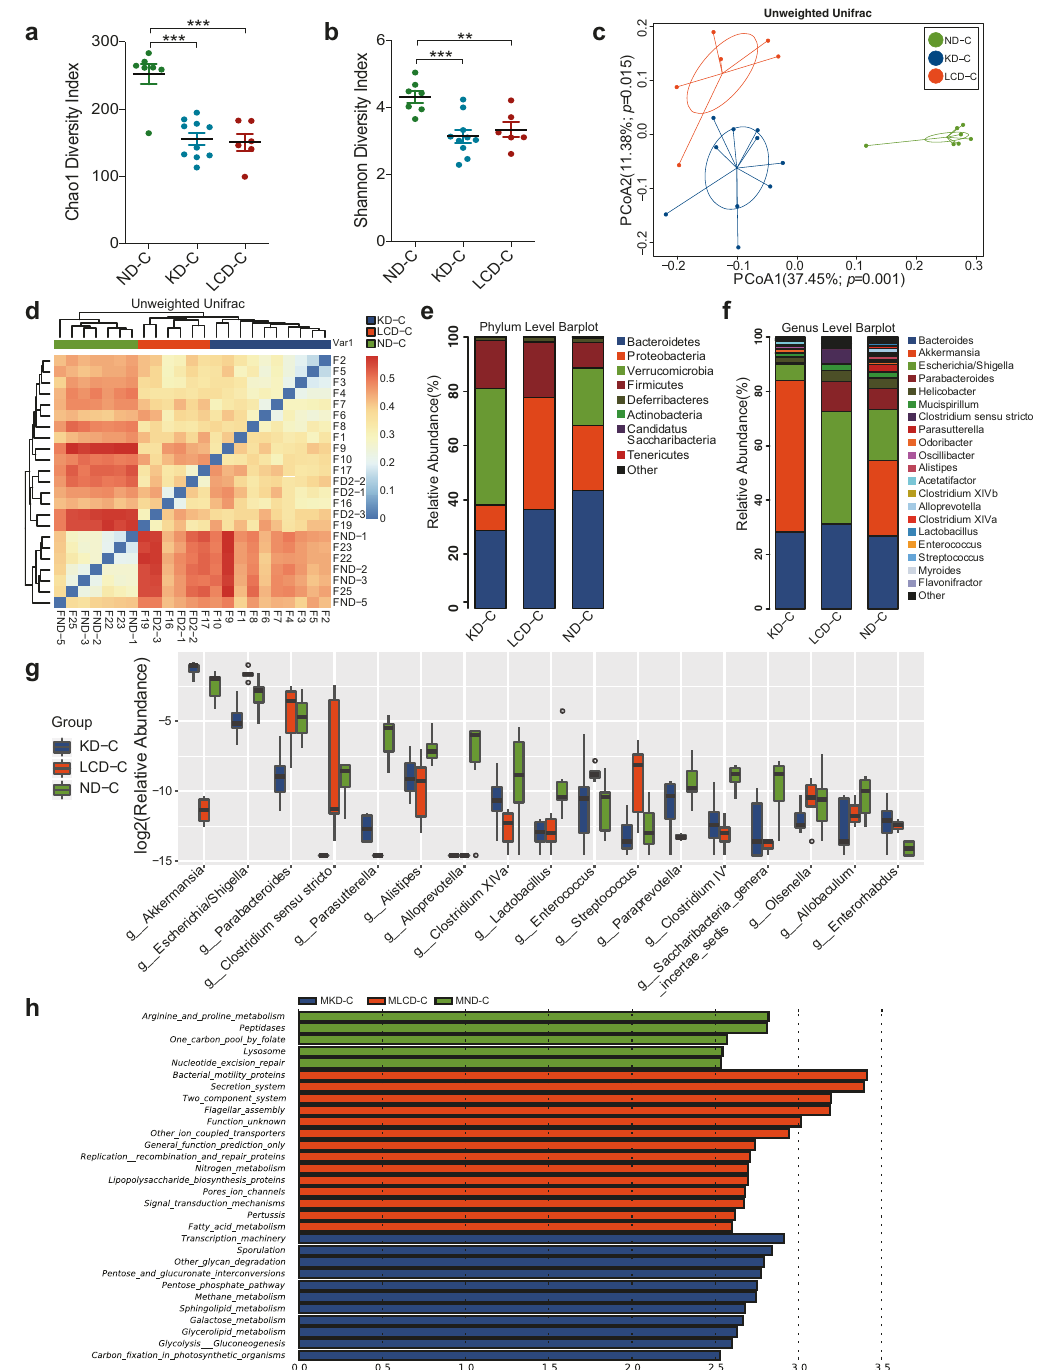
Fig. 5 Effects of KD and LCD on gut microbiota in mice with colitis. Effects of KD and LCD on gut microbiota in mice with colitis. a , b α - diversity Chao1 ( a ) and Shannon indices ( b ) in mice with DSS-induced colitis fed with a KD (KD-C), LCD (LCD-C), or ND (ND-C). c PCoA scores based on the relative abundance of operational taxonomic units (97% similarity). Each symbol represents a sample. d Unweighted UniFrac distance heatmap for each group. e , f Dominant phyla ( e ) and genera ( f ) in each group. g Relative abundance of genera between groups (Wilcoxon rank-sum test). The box presented the 95% CIs; the line inside denotes the median. h Differentially abundant KEGG pathways in the MLN of each group identi fi ed by LEfSe. LDA score >2.5, p < 0.05. ** p < 0.01; *** p < 0.001. (KD-C, n = 10; LCD-C, n = 6; ND-C, n = 7; MKD-C, n = 10; MLCD-C, n = 6; MND-C, n = 7). Results are expressed as mean ± SEM ( a – b ). KD ketogenic diet, LCD low-carbohydrate diet, ND normal diet, DSS dextran sulfate sodium, PCoA principal component analysis, MLN mesenteric lymph node, LEfS linear discriminant analysis effect